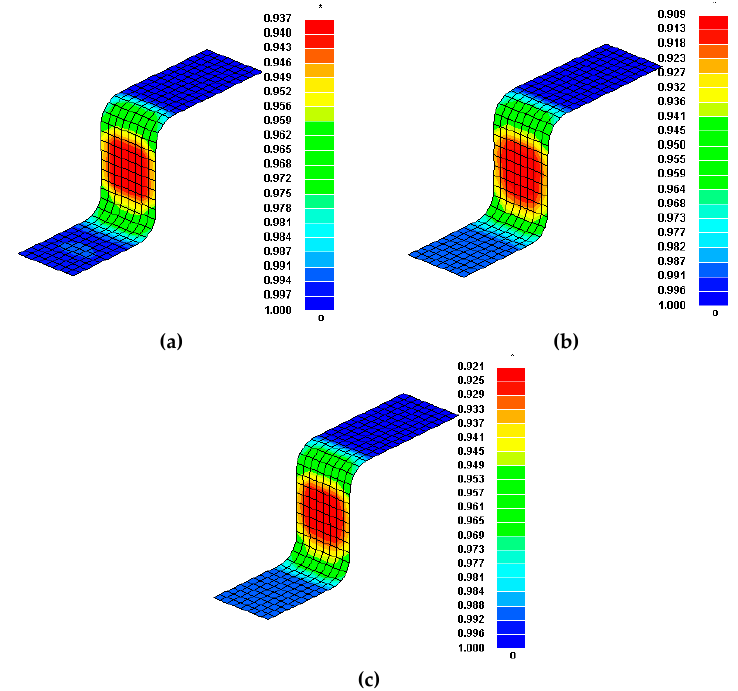
Figure 9. Thickness distributions under different friction coefficients of U-bending. ( a ) μ = 0.08; ( b ) μ = 0.12; ( c ) Variable friction coefficient model.